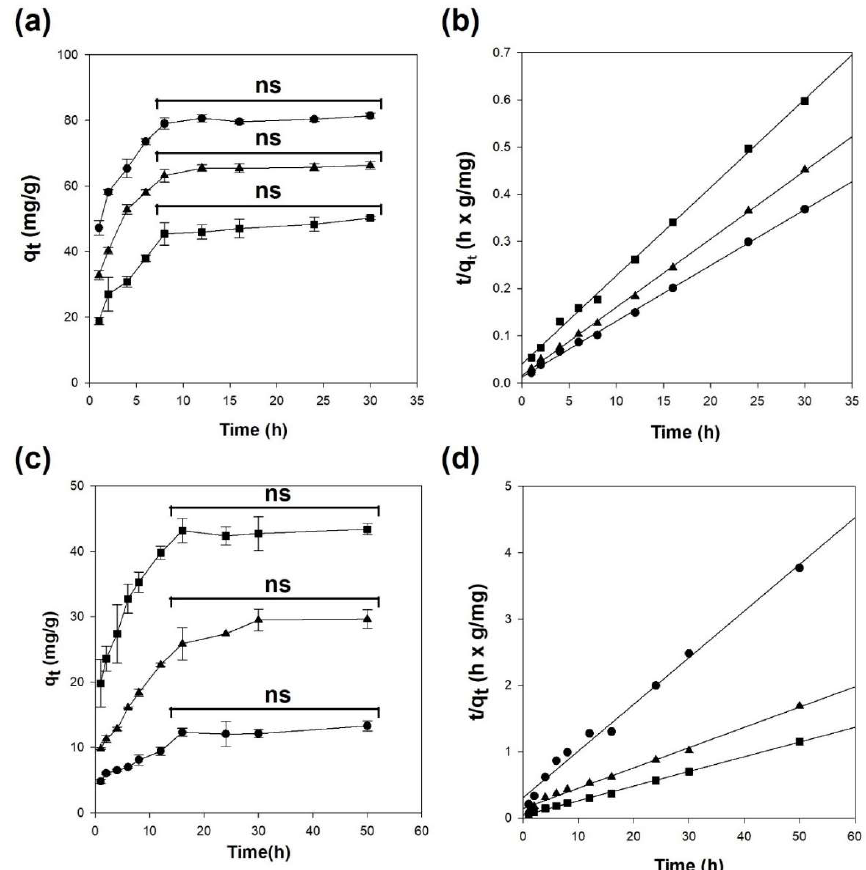
Figure 5. Kinetic studies of Cu 2+ ( a , b ) and benzene ( c , d ) adsorption onto alginate and alginate/bio-